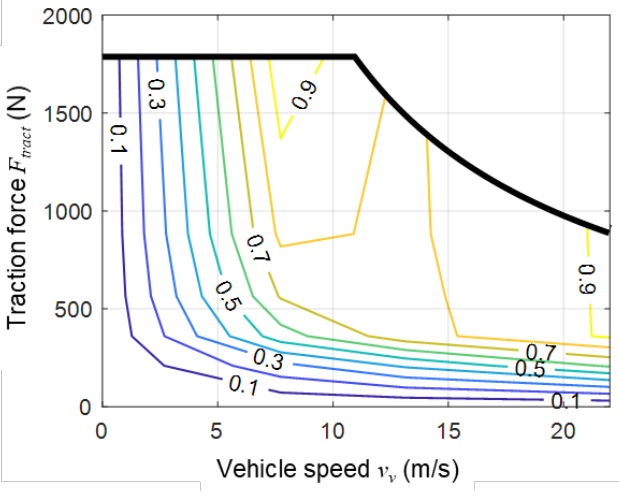
Figure 3. η tract Figure 3. η tract model.